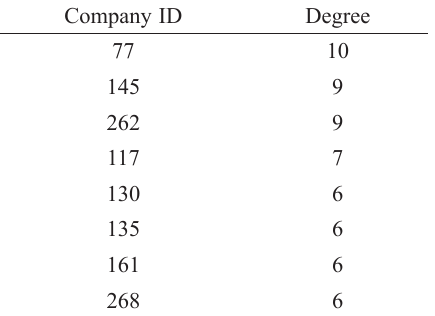
Table 2. The highest-degree companies of the general network